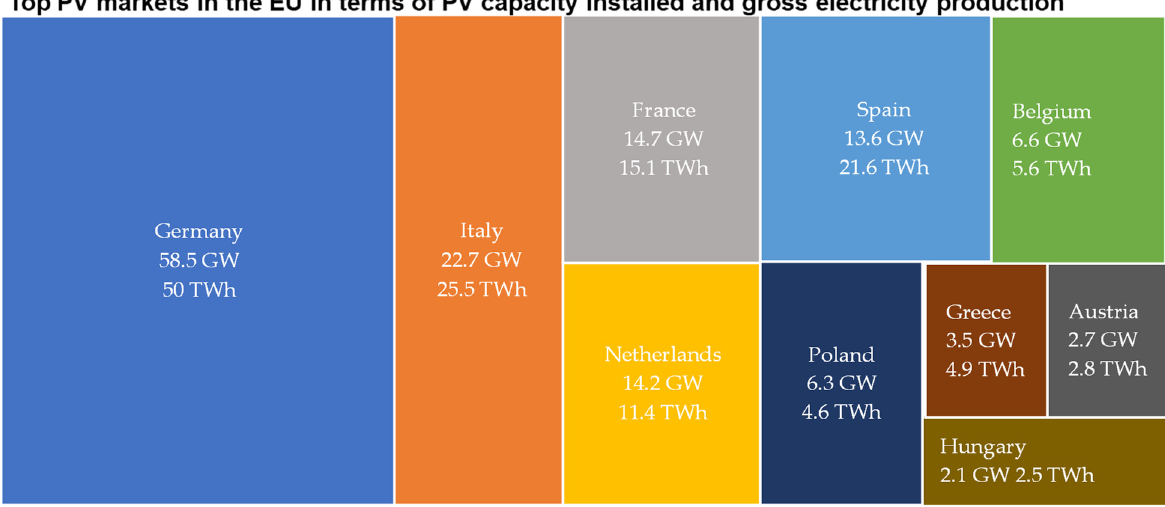
Figure 1. Characteristics of top PV markets in the EU—data for 2021.